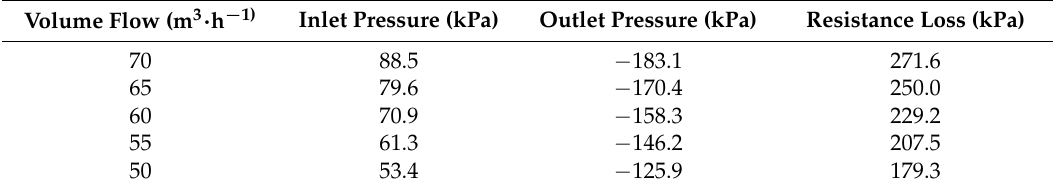
Table 3. Resistance loss of different slurry flows.